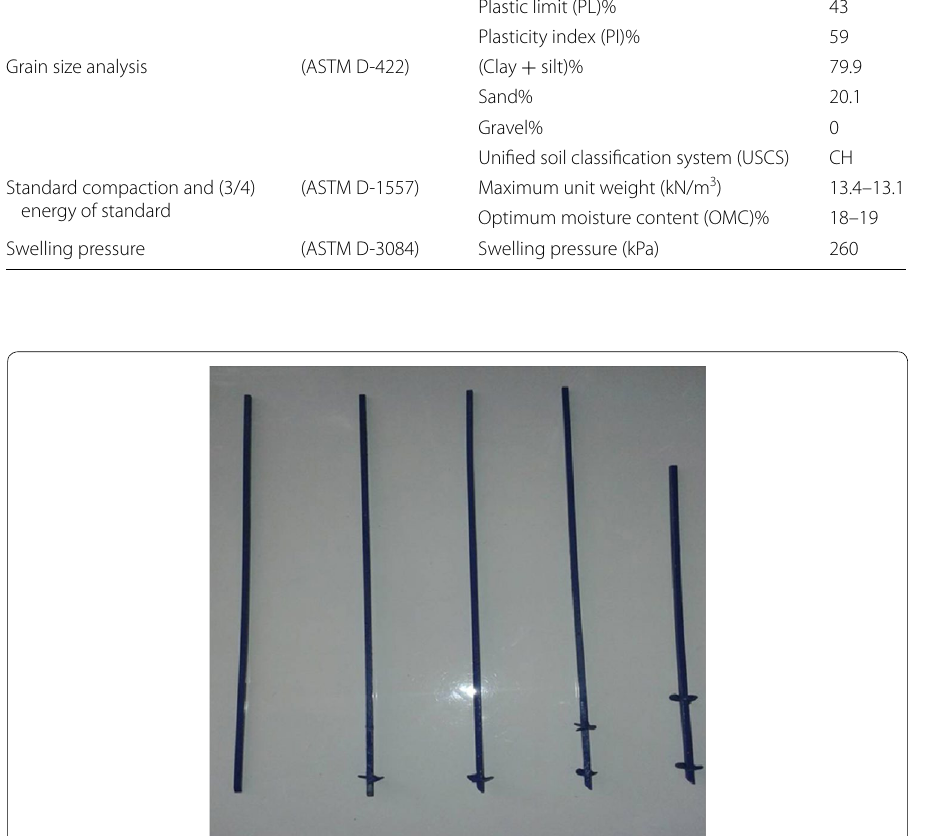
Fig. 1 Different types of helical piles used in the